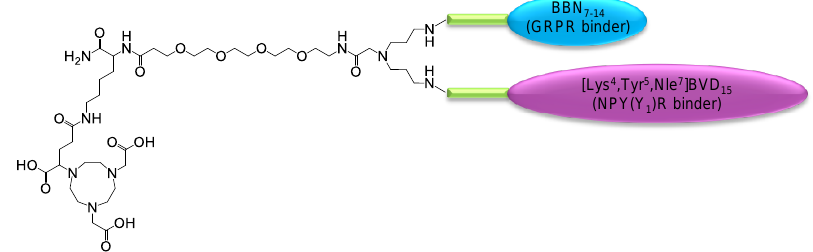
Figure 2. Schematic depiction of the general molecular design of the target HBPLs consisting of a chelating agent (NODA-GA), a short PEG 4 -linker between radiometal complex and peptides, the symmetrical branching unit, the linkers of different length and rigidity (green) and the GRPR- and NPY(Y 1 )R-binding peptides BBN 7-14 (cyan) and [Lys 4 ,Trp 5 ,Nle 7 ]BVD 15 (magenta).